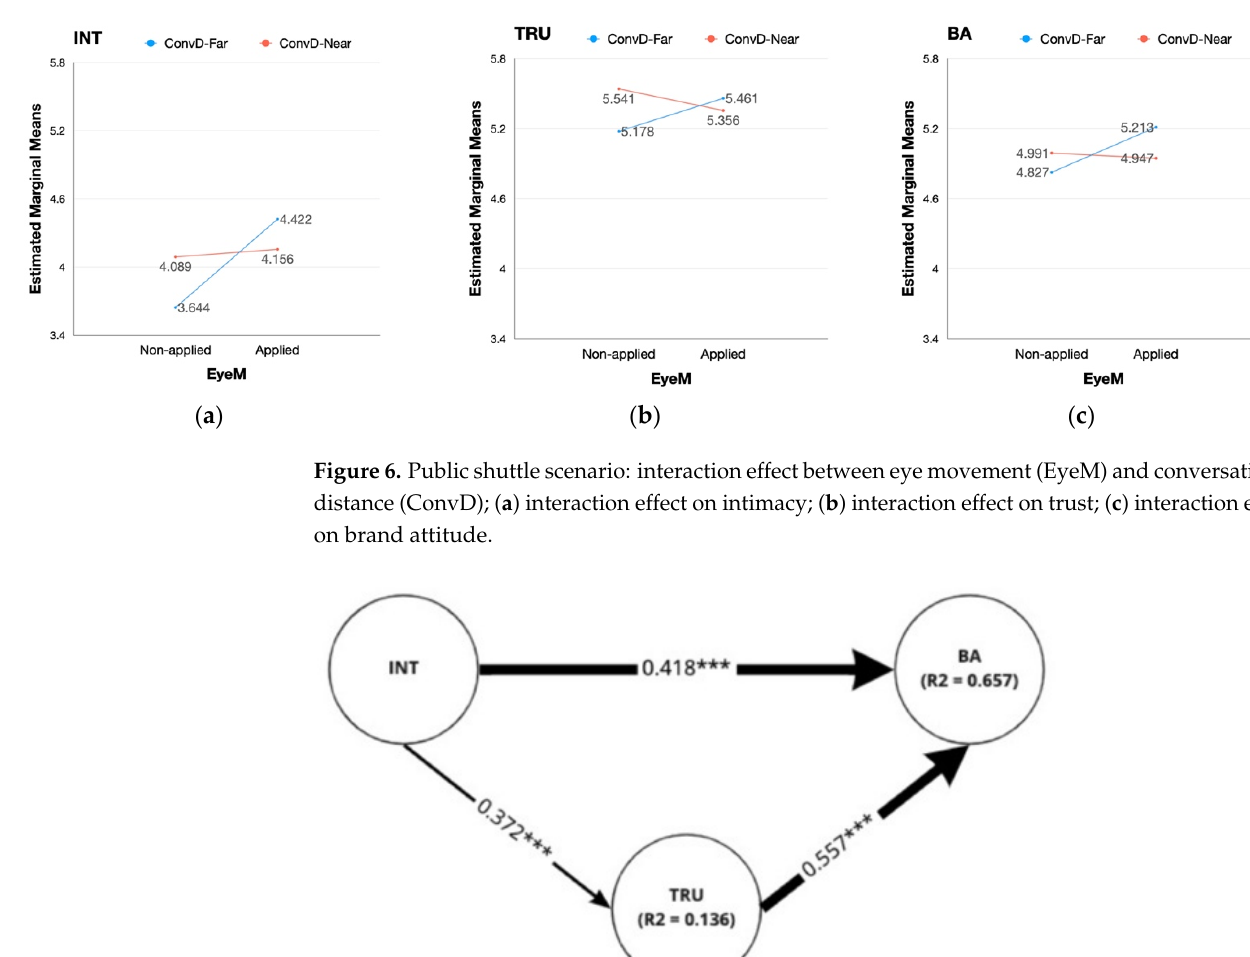
( c ) Figure 6. Public shuttle scenario: interaction effect between eye movement (EyeM) and conversa- tional distance (ConvD); ( a ) interaction effect on intimacy; ( b ) interaction effect on trust; ( c ) interac-